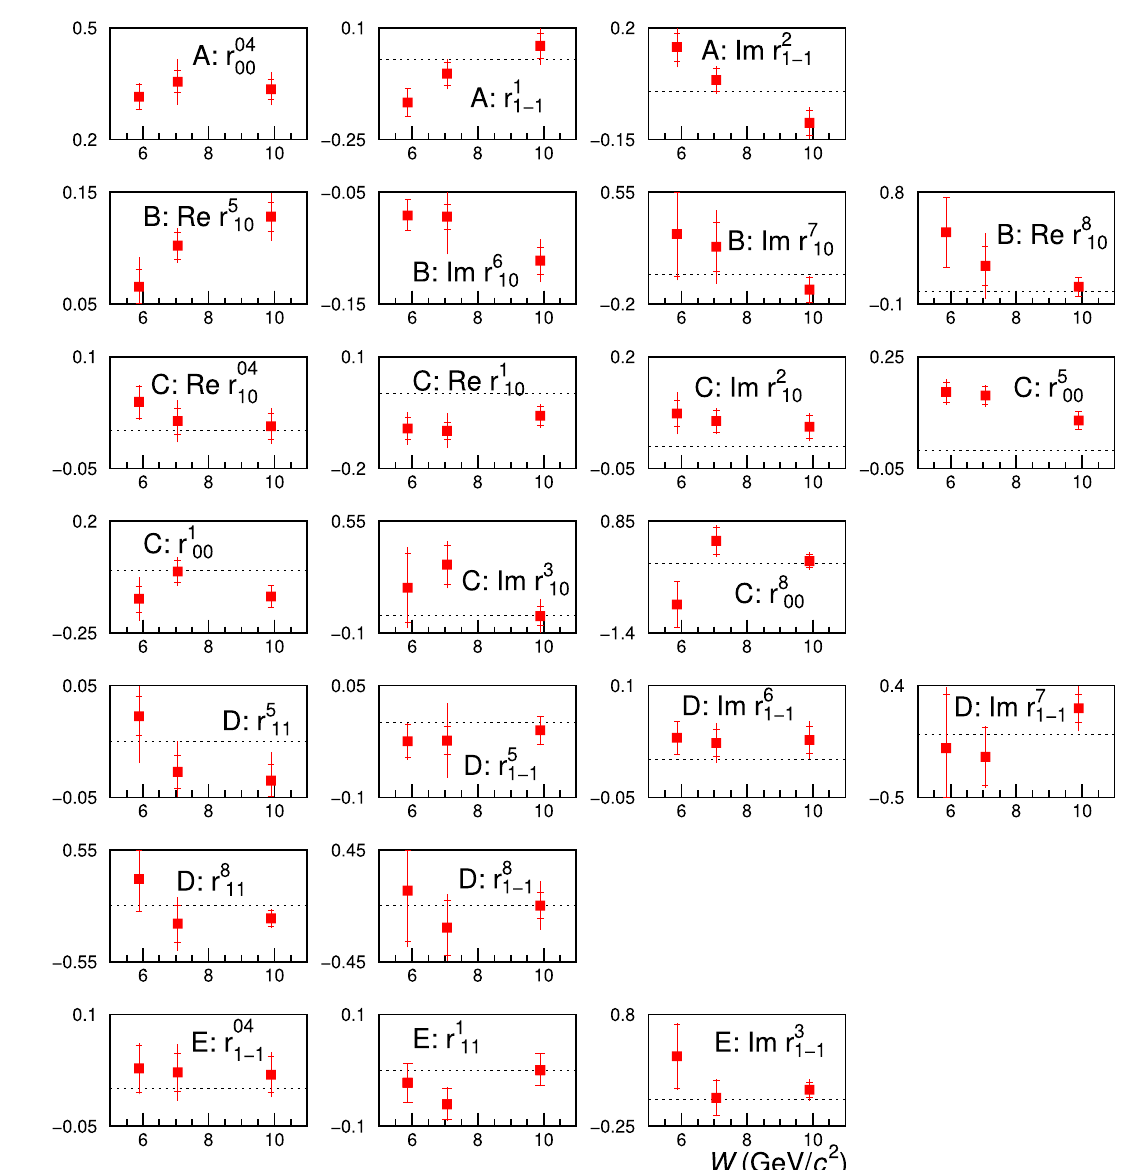
Fig. 8 W dependence of the measured 23 SDMEs. The capital letters A to E denote the class, to which the SDME belongs. Inner error bars represent statistical uncertainties and outer ones statistical and systematic uncertainties added in quadrature